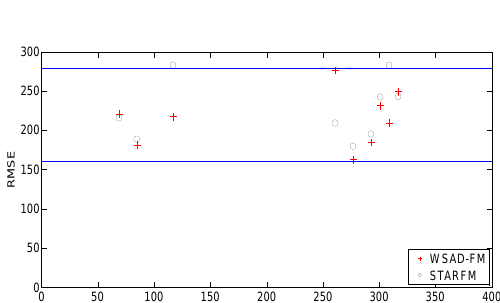
Figure 10. R 2 values for predicted red bands of Landsat images at time t p .